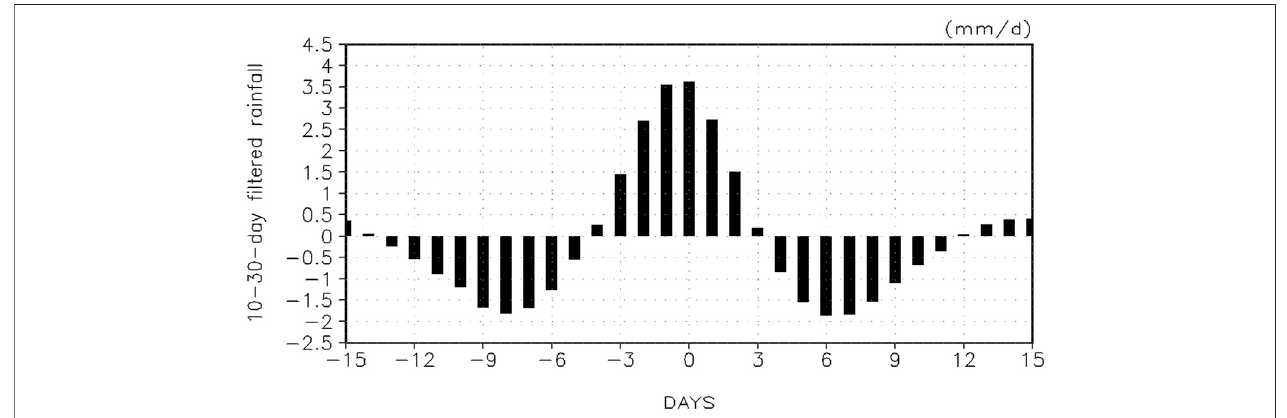
FIGURE3| Compositeevolutionofthe10-to30-day fi lteredprecipitationinsouthernChina(24 – 32 ° N,108 – 122 ° E)duringtherainfallQBWOeventsfromday-15to day 15, unit: